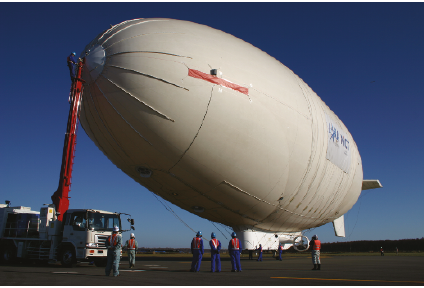
Figure 1: Photograph of the prototype stratospheric airship.